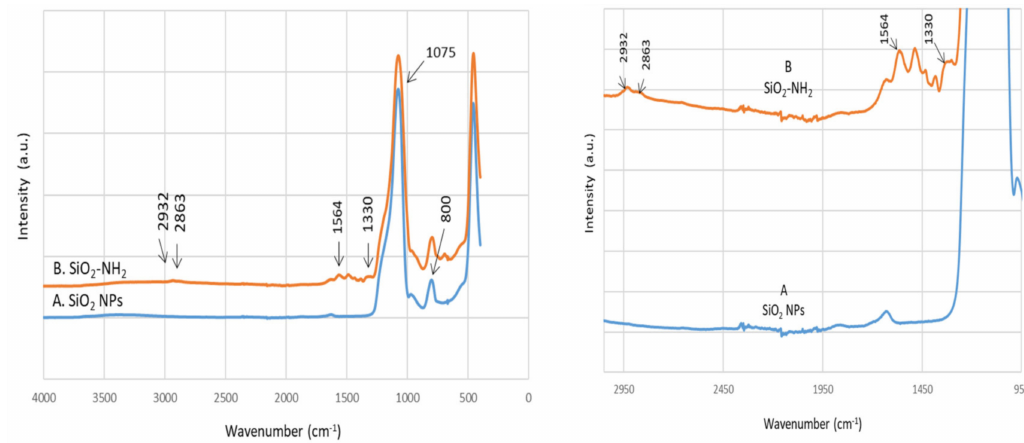
Figure 8. FTIR spectra of the ( A ) NS and( B )